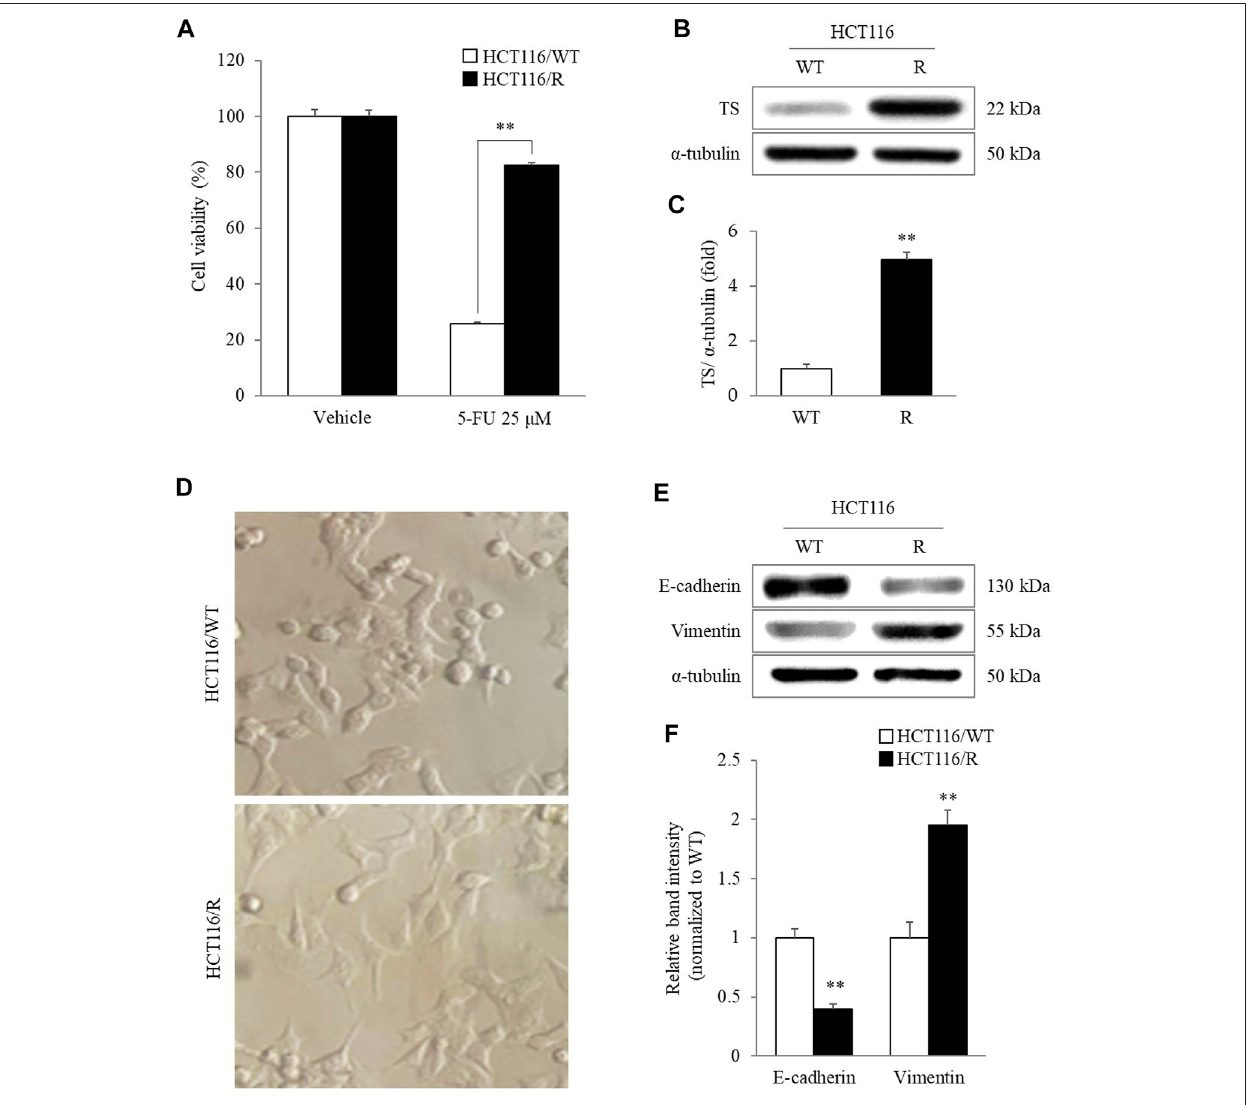
FIGURE 2 | Characteristics of HCT116/R cells. HCT116/R cells showed signi fi cant resistance to 5-FU compared to HCT116/WT cells (A) . The cellular protein levels of TS were analyzed using western blotting (B) and quanti fi ed by ImageJ software (C) . Characteristics of EMT in HCT116/R cells were observed by assessing morphological changes under a phase-contrast microscope (400 X) (D) and by measuring the protein levels of E-cadherin and vimentin using western blotting (E) and quantifying these data (F) . The data are expressed as the mean ± SD value ( n = 3). ** p < 0.01, compared with HCT116/WT cells. 5-FU, 5- fl uorouracil;